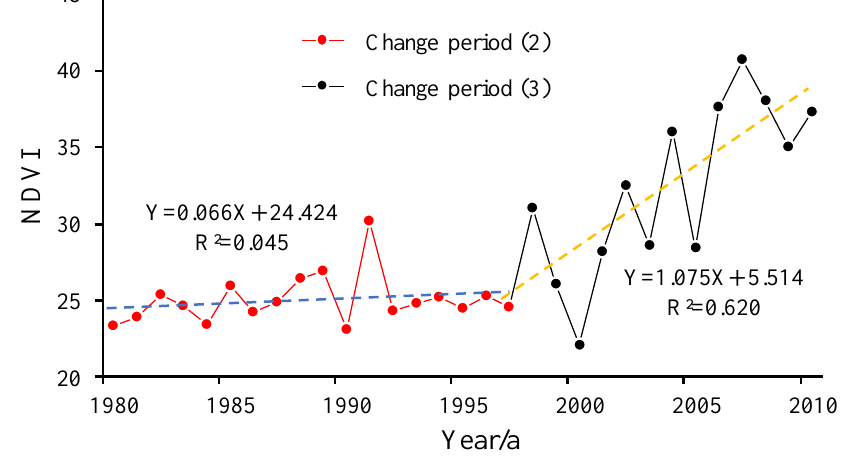
Figure 7. Annual NDVI variation trend in different periods in Chabagou River Watershed.